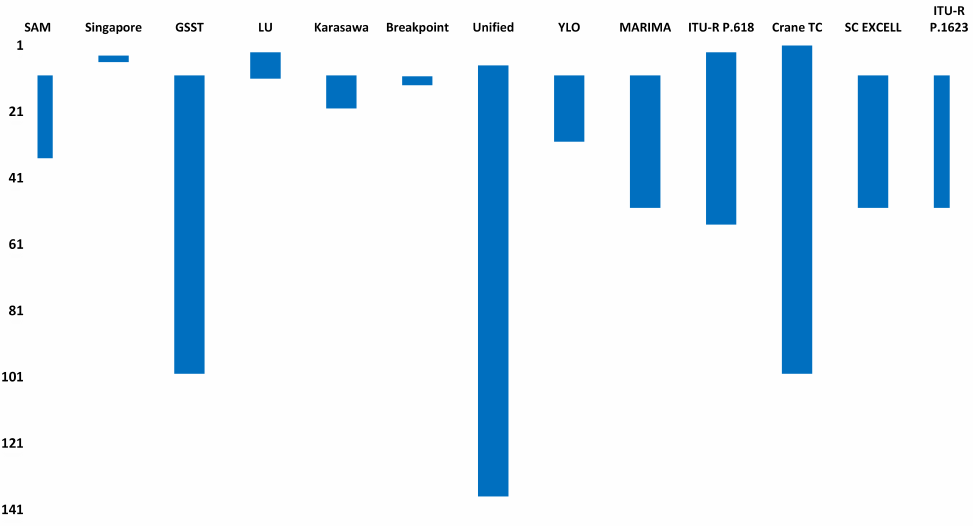
Figure 6. Each“vertical bar” represents the supported frequency range of the studied models. The vertical axis represents frequency in GHz and the horizontal axis represents the